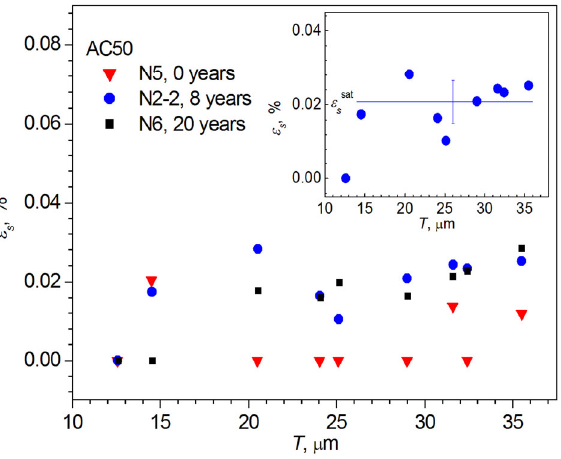
Figure 18. Distribution of microstrain ε s = ε s hkl along the depth T from the surface of the AC50 wire. The microstrain ε s hkl is estimated under the assumption of a fixed crystallite size equal to the crystallite size D 12.5 μ m near the surface (at a depth of T ~ 12.5 μ m). Sample numbers according to Table 2 and their service lifetimes are shown. The inset shows an example of estimation of the average microstrain ε s sat in the NSDL at depths T ≥ 15 μ m, if the crystallite size is fixed and equal to the crystallite size D 12.5 μ m .